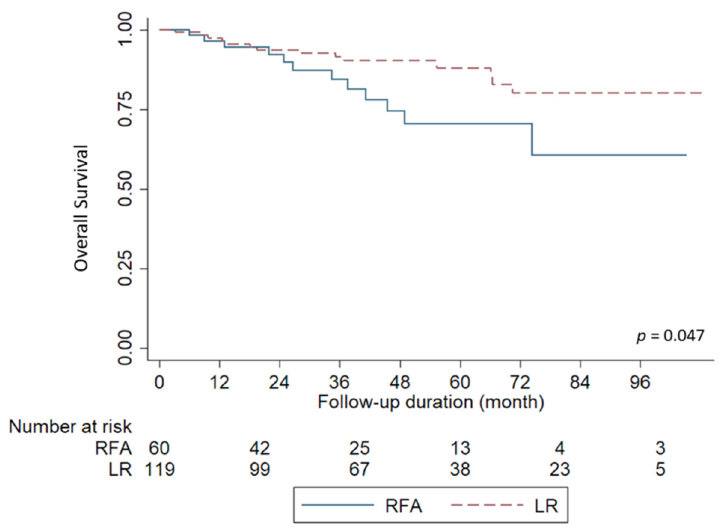
Figure 2. Comparison of overall survival based on the treatment modalities. Liver resection (LR) had a significantly better overall survival than radiofrequency ablation (RFA) for patients ( p < 0.047).